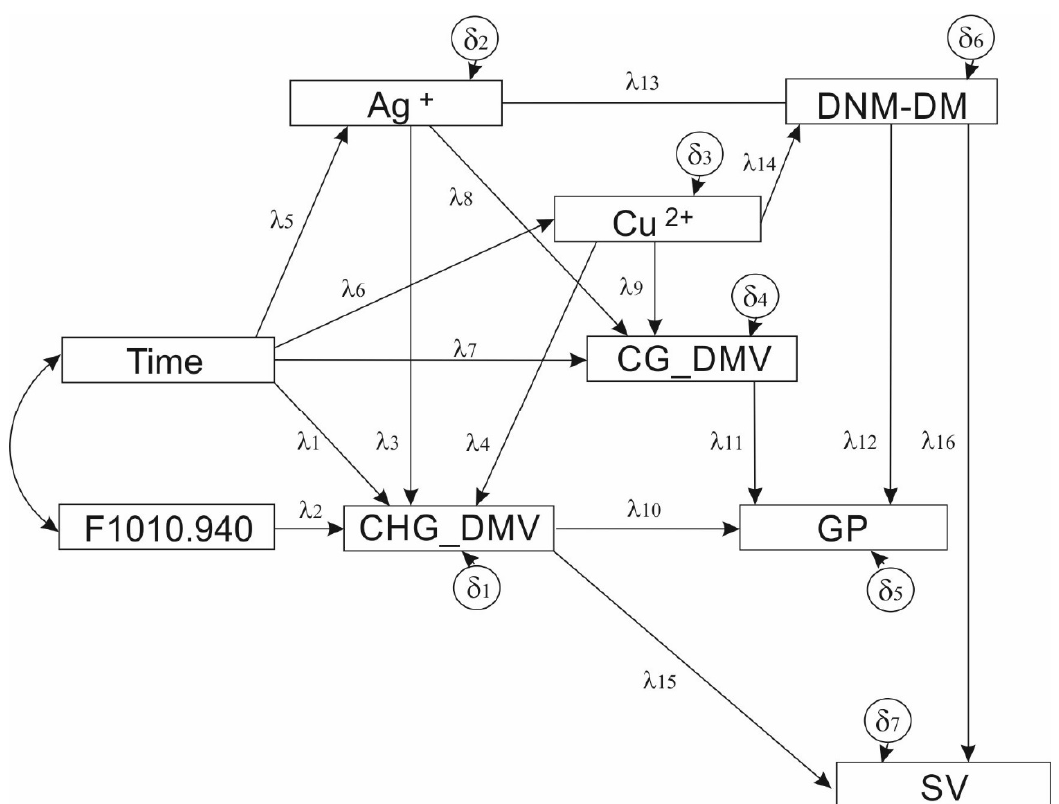
Figure 1. The path diagram is a graphical representation of the structural equation model. Rectangles represent observable endo- and exogenous variables, whereas circles are random errors for endogenous variables (denoted by delta symbols). One-way arrows illustrate causal relationships between variables. Path coefficients are marked by lambda parameters. The semicircular bidirectional arrow represents the presence of covariance between exogenous variables in the model. Time represents the duration of anther culture; CHG_DMV and CG_DMV represent the DNA demethylation of the CHG and CG sequence contexts, respectively, determined using metAFLP markers [9,48]; SV represents sequence variation evaluated using the metAFLP approach; DNM-DM is the difference between de novo methylation and DNA demethylation, evaluated using the DArTseqMet approach [54,56]; GP is the number of green plants regenerated per 100 anthers via in vitro anther culture of barley [43]; Cu 2+ and Ag + represent ion concentrations present in the tissue culture medium [9,43]. The F1010.940 is the ATR-FTIR spectral range assigned to β -glucans (1010–940 cm − 1 )